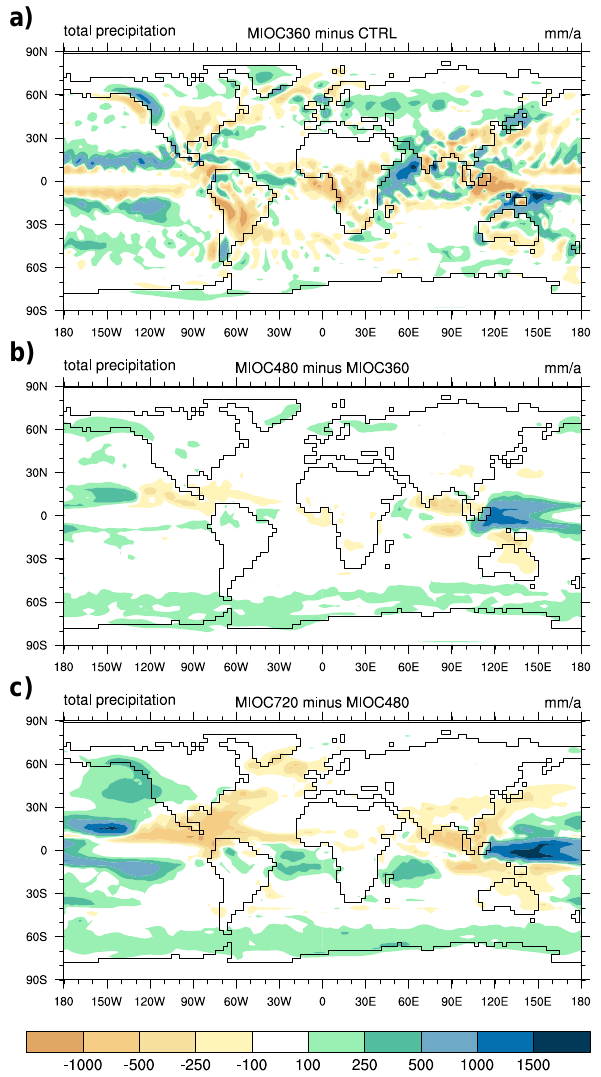
Fig. 4. Differences in total precipitation between (a) MIOC360 and CTRL, (b) MIOC480 and MIOC360, and (c) between MIOC720 and MIOC480 (in mma − 1 ).